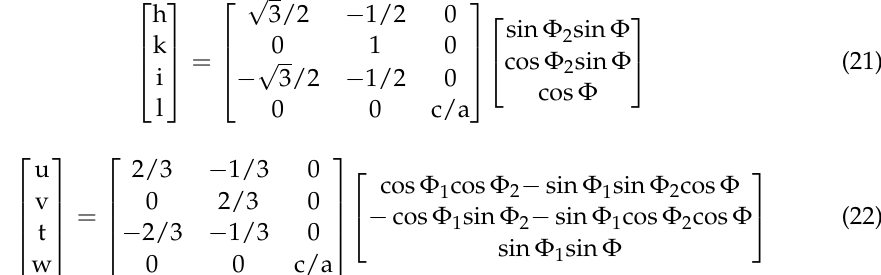
Figure 10. The ODF at different temperatures at a strain rate of ε (cid:4662) = 1 × 10 − 2 s − 1 : ( a ) 300 °C; ( b ) 350 °C; ( c ) 400 °C; ( d ) 450 °C; ( e ) 500 °C.